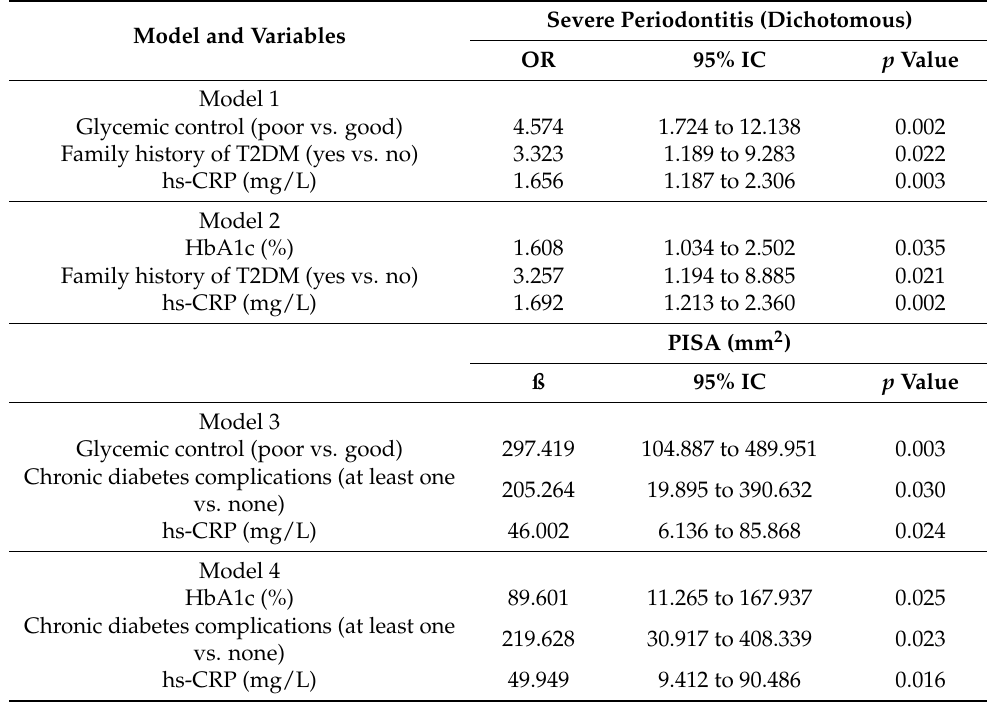
Table 3. Association between severe periodontitis and glycemic control.